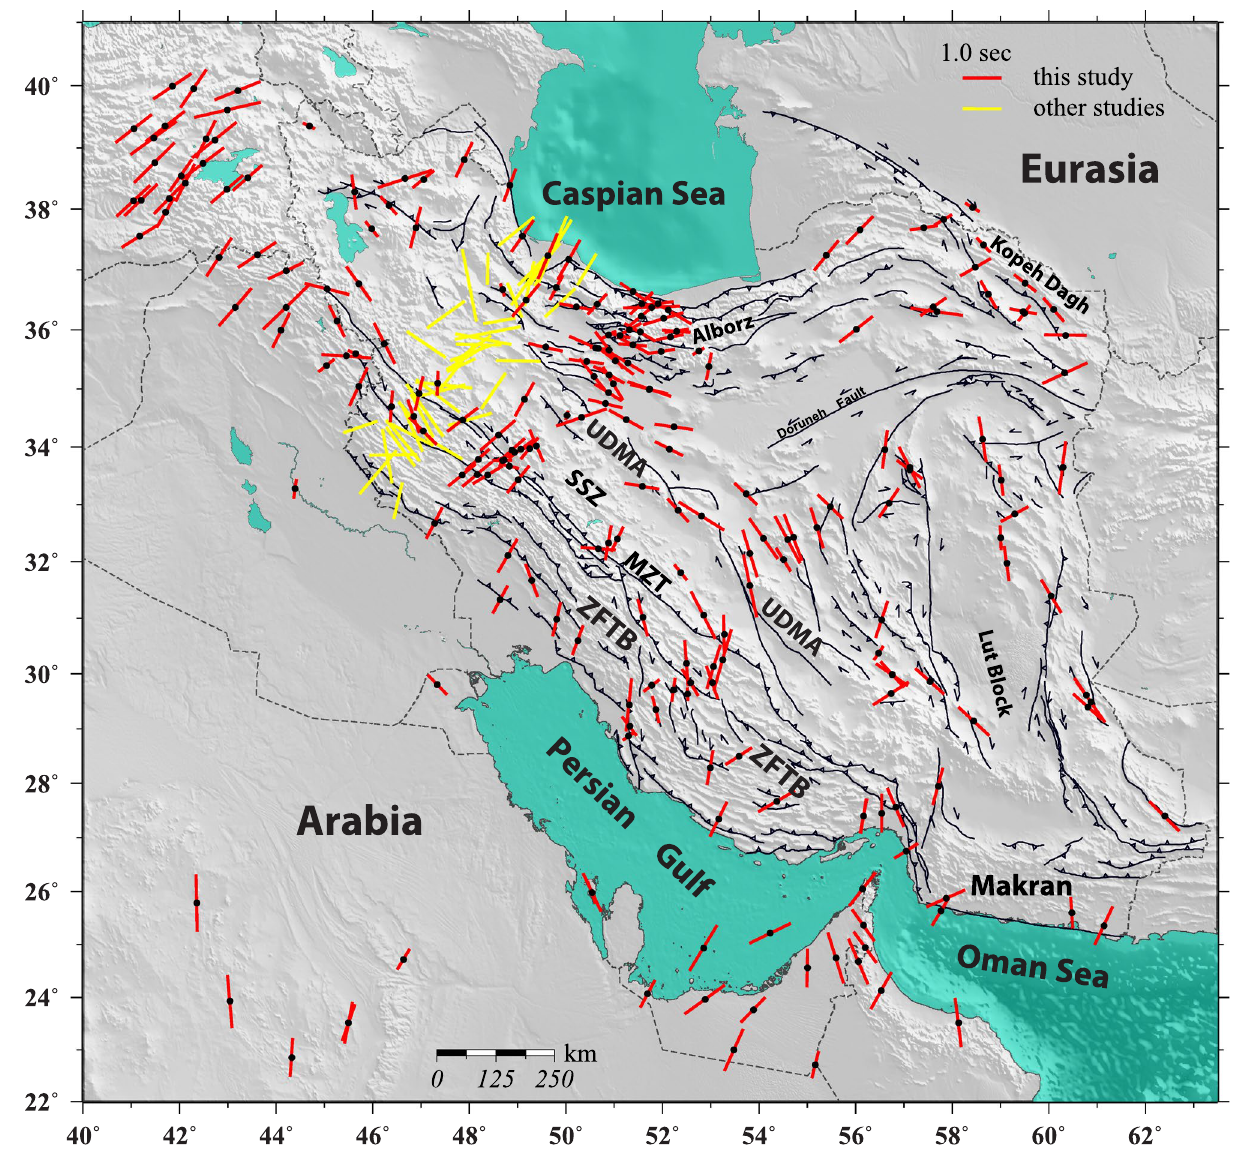
Figure 2. The results of one-layer anisotropic inversion for each station (red bars). Yellow bars illustrate results from previous studies. Each bar is oriented along the fast direction of the one-layer model and its length is proportional to the amount of split time. Map is generated using the GMT 60